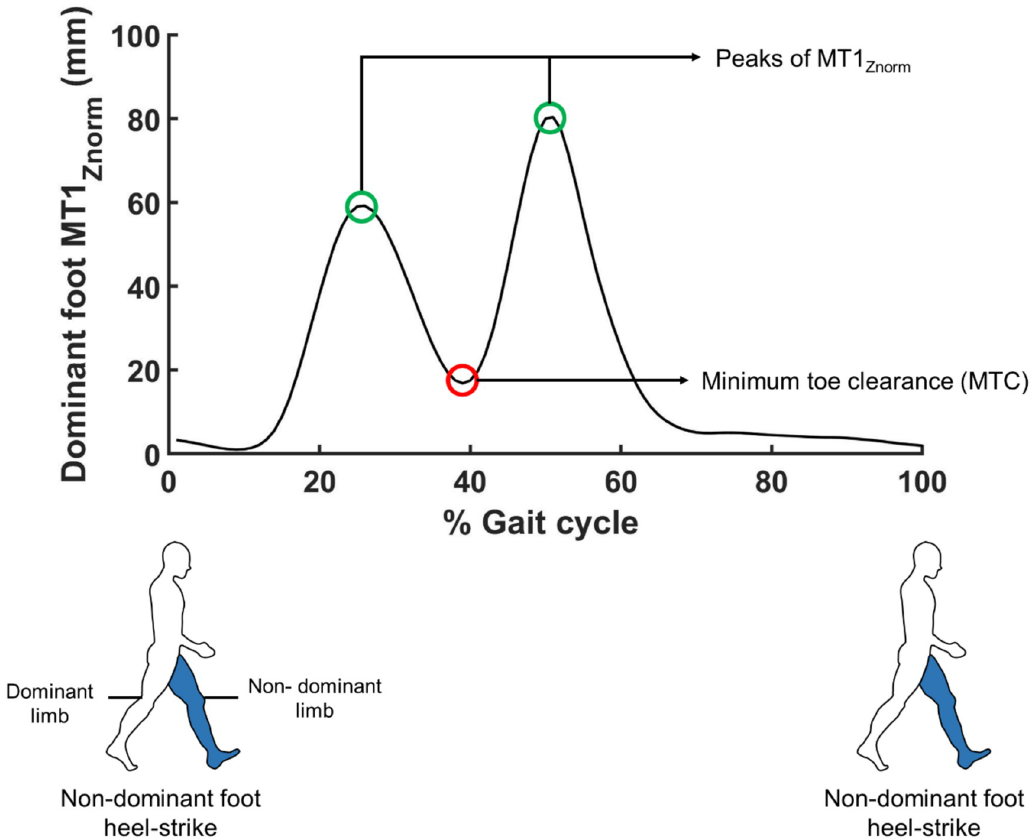
Fig 2. Illustration of the process of detecting MTC. MTC is obtained from the trajectory of the reflective marker attached to the first metatarsal in the vertical direction (MT1 Z ). The average MT1 Z during the three-second standing is set as the baseline position of the toe. This average value is subtracted from the entire original MT1 Z profile and the resulting profile is labeled as MT1 Znorm . Each gait cycle of one leg is defined as the period from a heel-strike (HS) to the subsequent HS of the other leg. (The figure shows the example of one gait cycle defined to calculate MTC of the dominant foot.) The MT1 Znorm during one gait cycle exhibits two peaks (green circles). MTC is defined as the lowest MT1 Znorm between these two peaks (red circle).